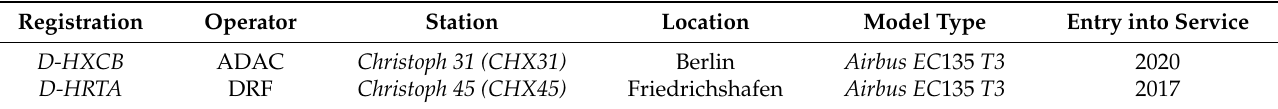
Table 2. Overview of the selected helicopters.